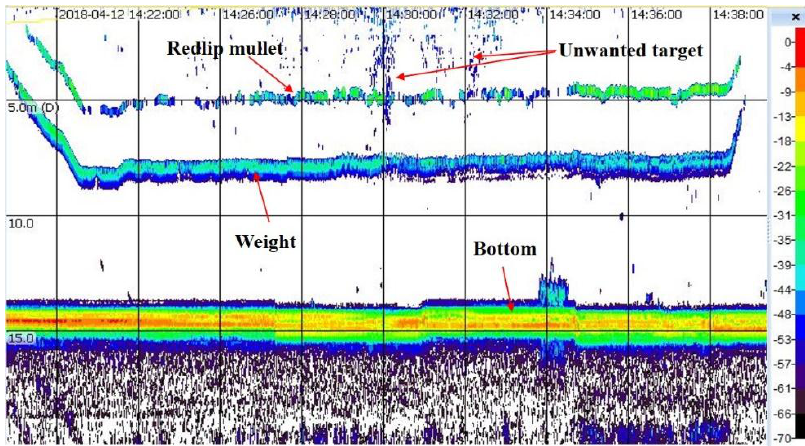
Figure 3. A sample echogram of the Redlip mullet ( FL : 35.0 cm) from the ex situ target A sample echogram of the Redlip mullet ( FL : 35.0 cm) from the ex situ target strength measurements. strength